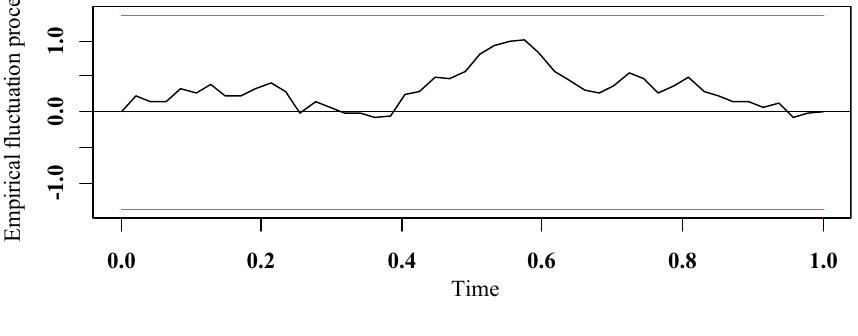
Fig. 4 The OLS-based CUSUM process of VAR(p) model